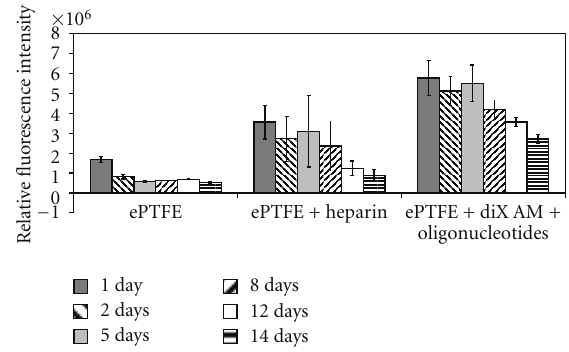
Figure 10: Viability of HUVECs on standard blood vessel graft materials (ePTFE and ePTFE coated with heparin) and on ePTFE coated with diX AM and oligonucleotides over a period of 14 days. Metabolic activity of cells was significantly higher for each time point on oligonucleotide-coated ePTFE compared to ePTFE or ePTFE with heparin ( P < 0 .